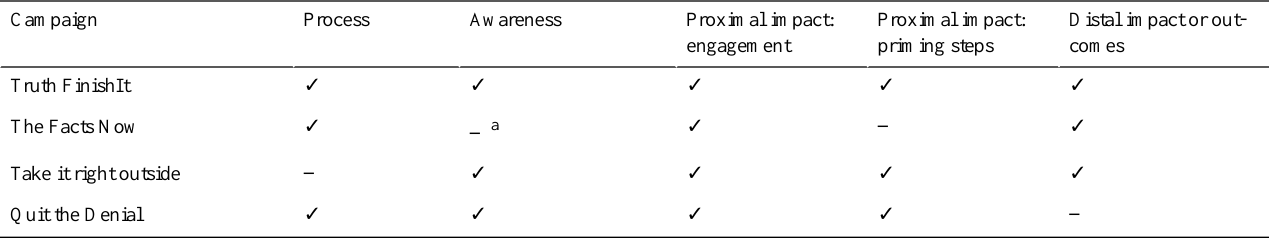
Table 3. Reported evaluation measures in awareness raising and social norm change campaigns.